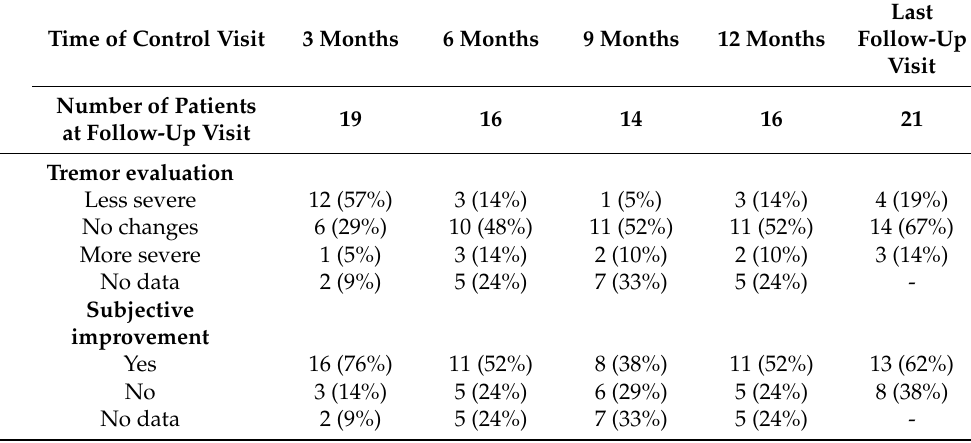
Table 4. Treatment results of the whole